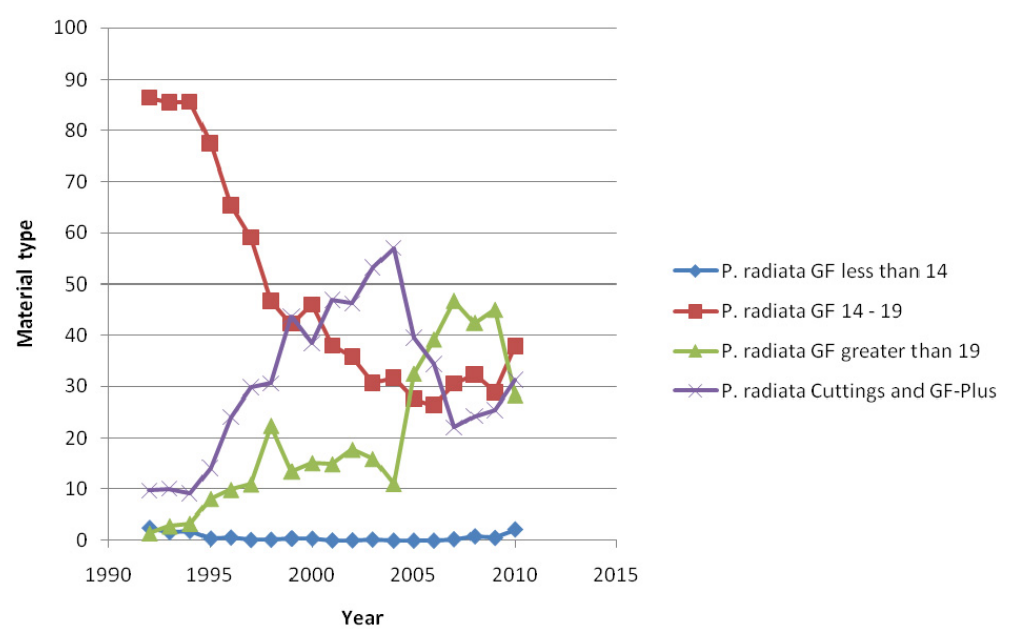
Figure 3. Quality of planting stock deployed in New Zealand’s radiata pine plantations over the past 20 years, based on nursery sale